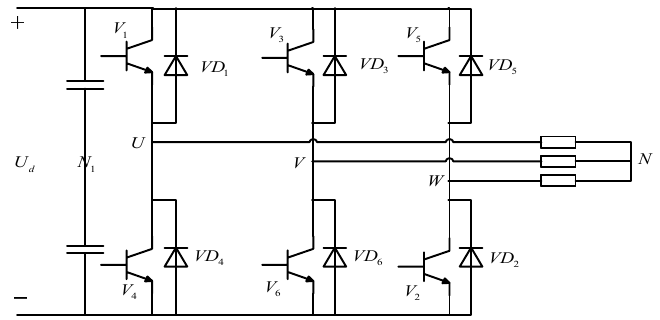
Figure 7. Inverter structure diagram.